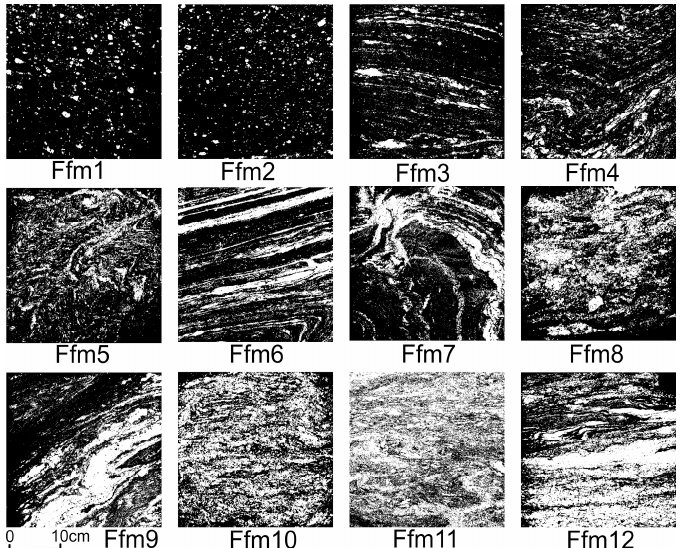
Figure 11. Processed black and white 30 × 30 cm 2 image frames of the metatexite and diatexite